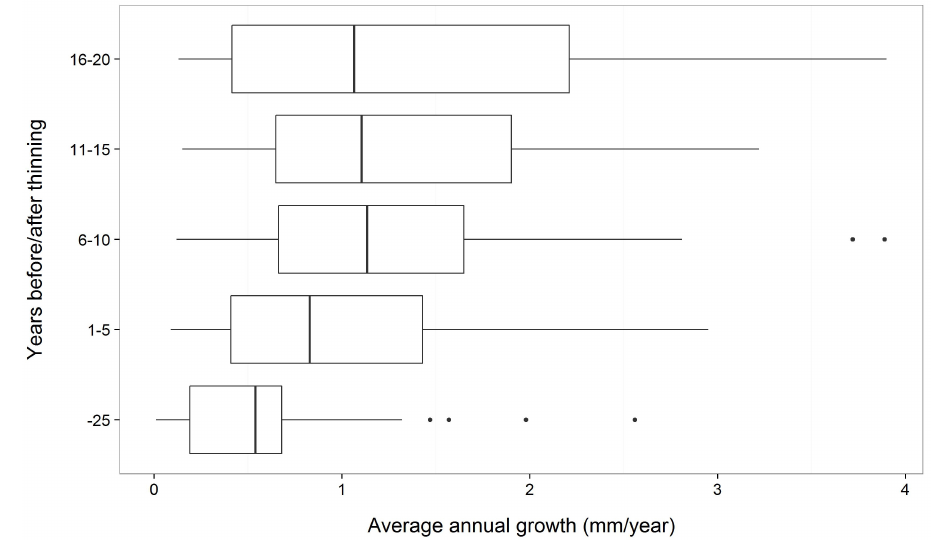
Figure 2. Average annual growth of WBP before and after thinning of competitors. Data from Keane et al. [79].